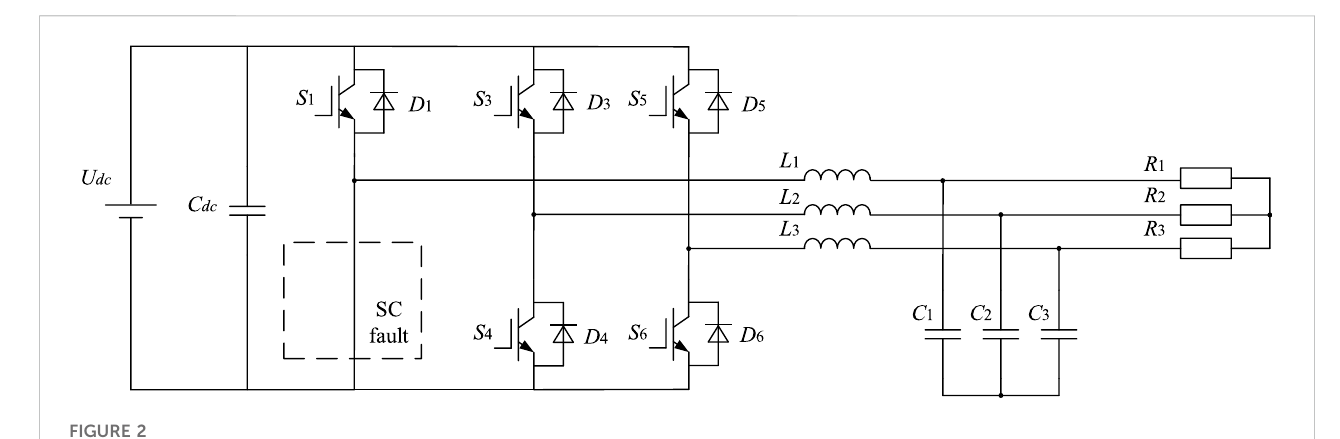
FIGURE 2 Topology of three-phase inverter with SC fault of S 2